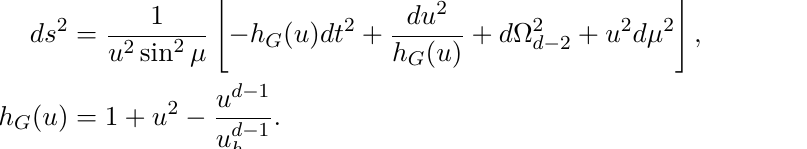
gravitating d +1 brane d . Note b